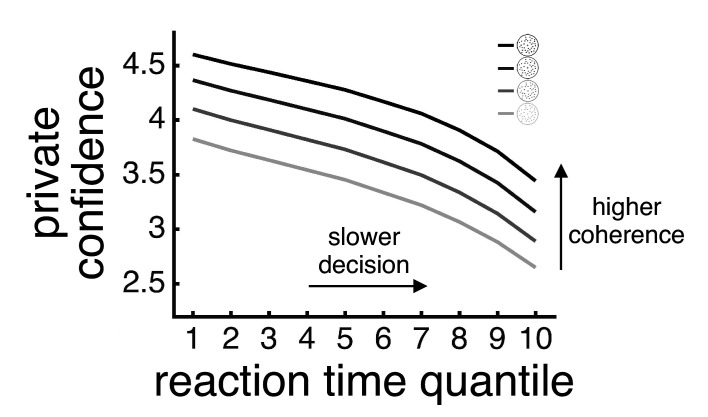
Model-based estimate of private confidence varies with both motion coherence and choice reaction time.For each subject, we used the model fitted to their data (see Figure 4A) to estimate private confidence (y-axis) for each level of motion coherence (lines) and for 10 choice reaction times specified using quantiles (x-axis). We then averaged the model-based estimate of private confidence across subjects for visualisation.